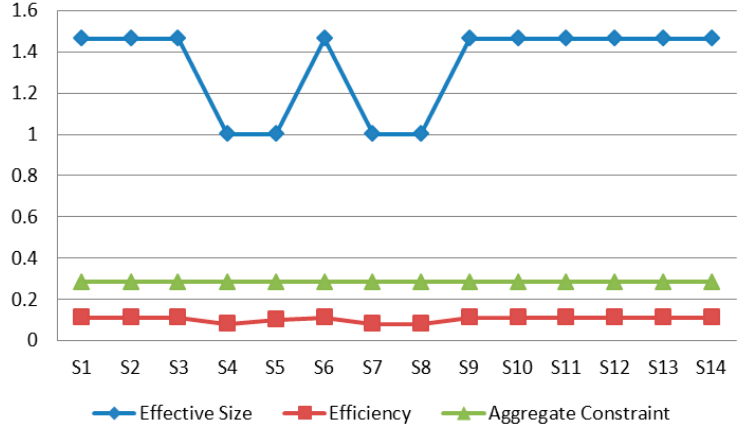
Figure 5. Structural holes for the stakeholder network.